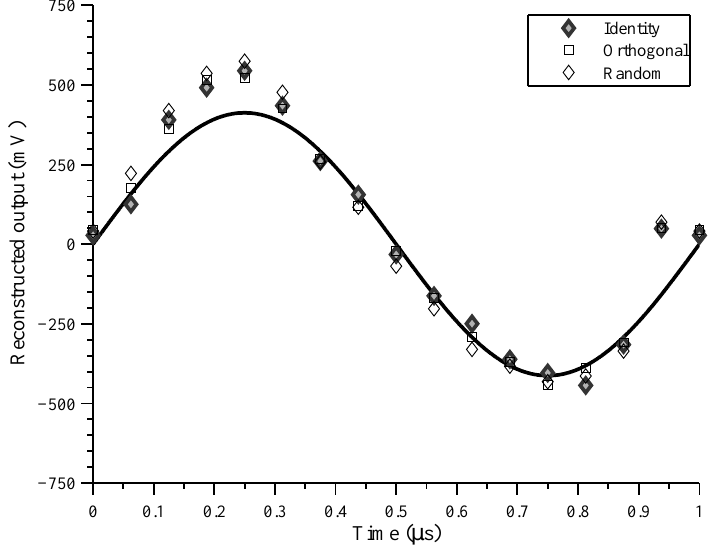
Figure 12. 1 MHz sine wave input with output offset corrected using the full chipping sequence complement.